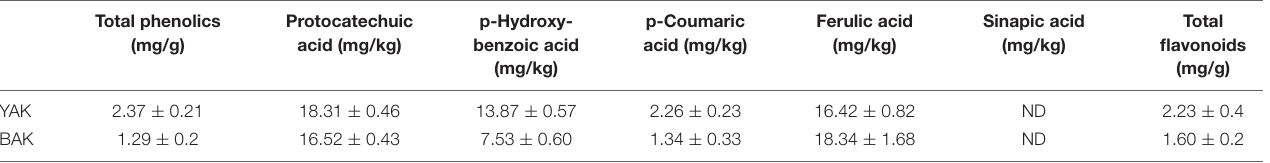
TABLE 2 | | Phenolics and flavonoid content in khambir samples.